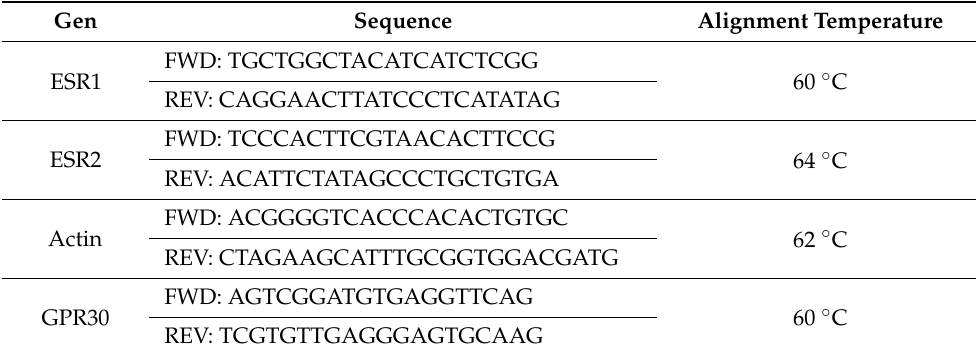
Table A1. Forward and reverse sequences of genes ERS1 , ERS2 , GPR30 and Actin.